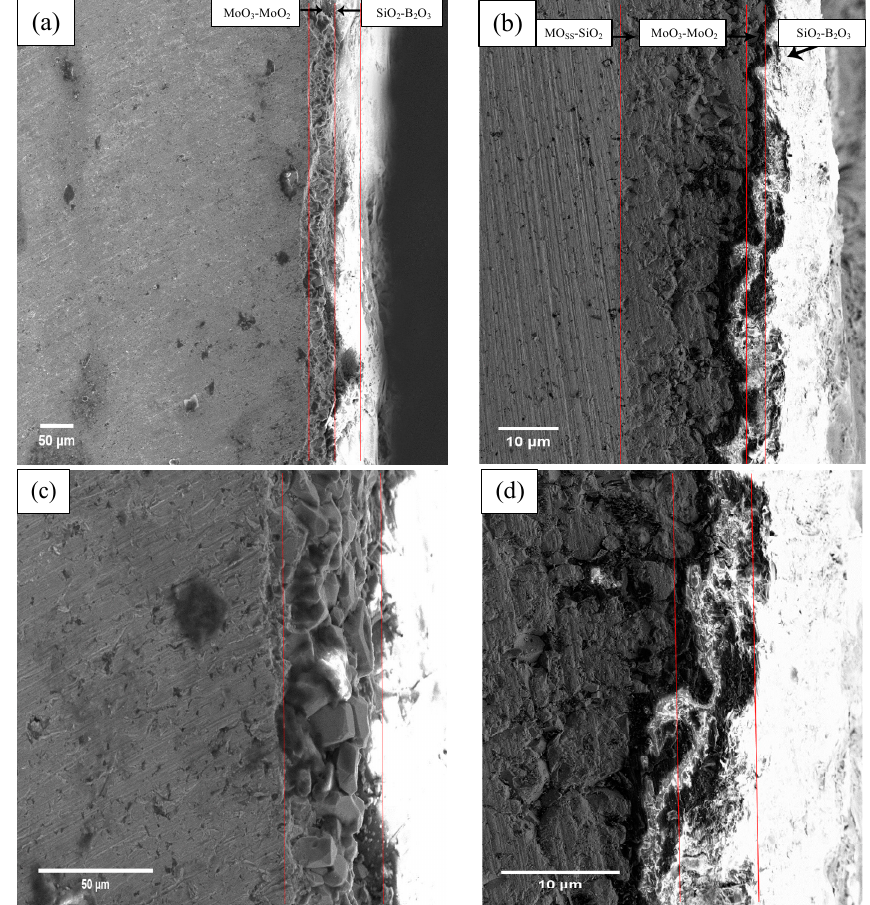
Figure 6. Oxidation diagram of Mo–3Si–1B–1Zr–1Y 2 O 3 alloy. ( a , c ) show the cross-section Figure 6. OxidationdiagramofMo–3Si–1B–1Zr–1Y 2 O 3 alloy. ( a , c )showthecross-sectionmicrostructures microstructures exposed at 800 °C; ( b , d ) show the cross-section microstructures exposed at 1200 °C . exposed at 800 ◦ C; ( b , d ) show the cross-section microstructures exposed at 1200 ◦